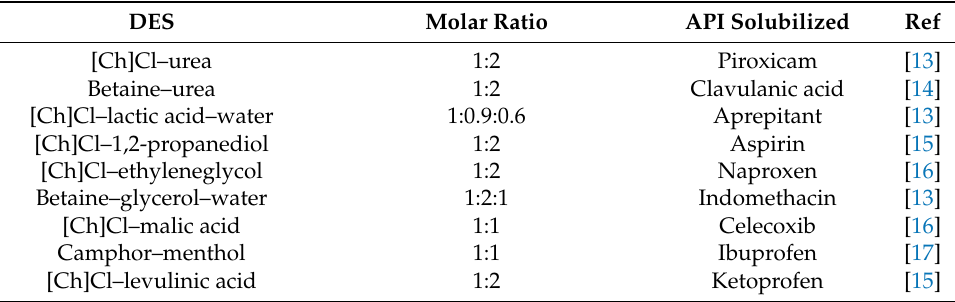
Table 1. DES application as alternative media for API solubilization and API formulation into its liquid form by the API–DES